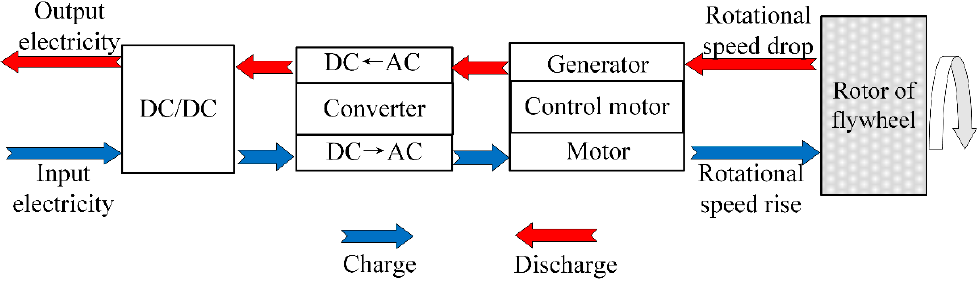
Figure 2. Flywheel battery energy flow .